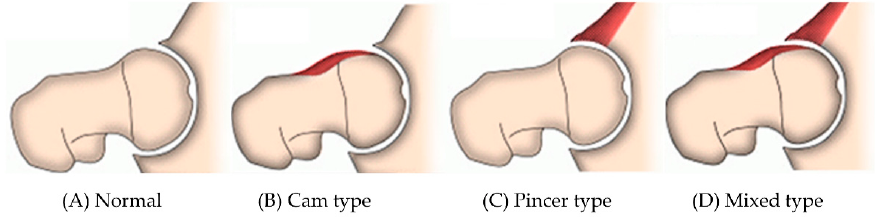
Figure 1. Normal and femoroacetabular impingement type.